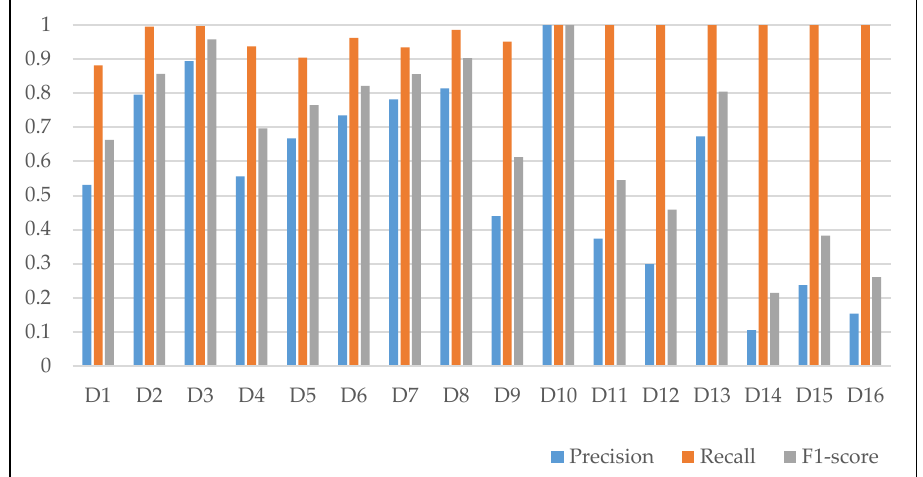
Figure 4. Precision, Recall, and F1-score for the positive samples of 16 datasets.